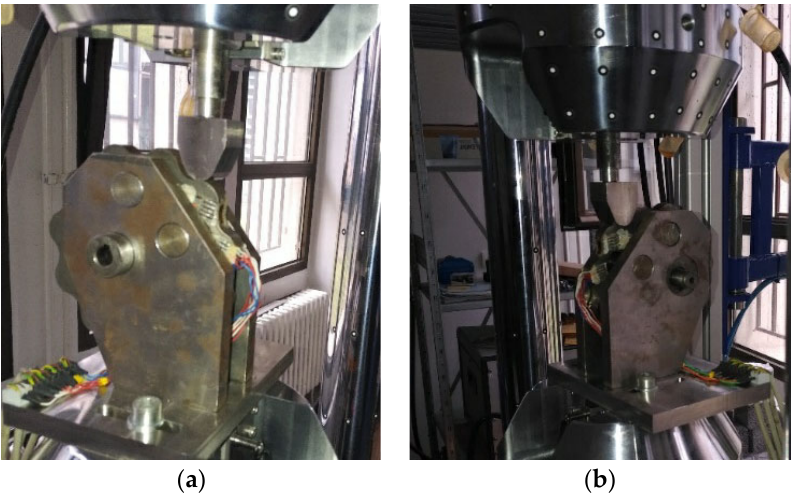
Figure 5. The experimental model on the servo-hydraulic pulsator: ( a ) left side view; ( b ) right side view 2.